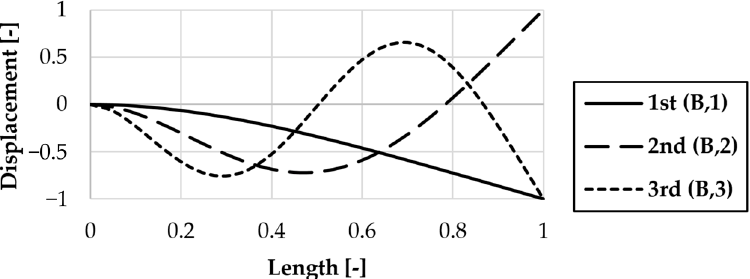
Figure 2. Normal bending modes of the beam.